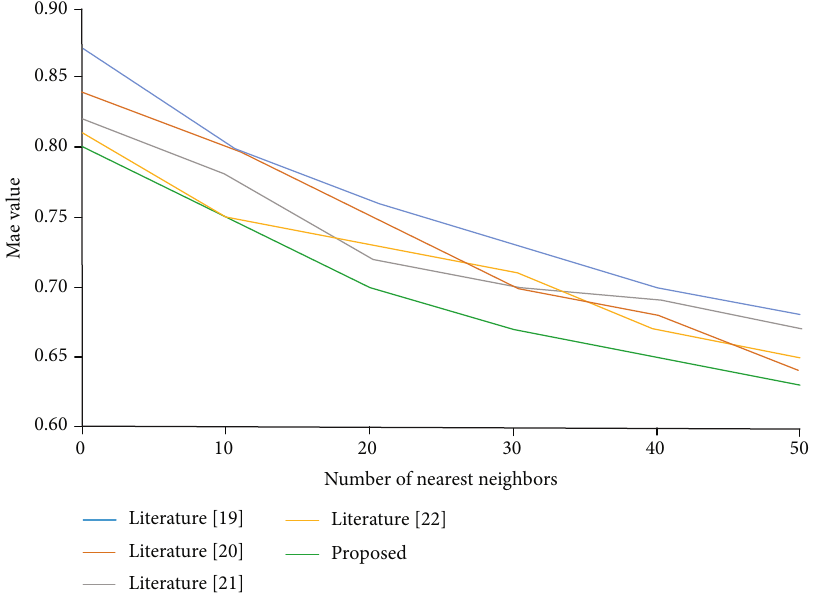
Figure 6: MAE values of each algorithm. Table 3: RMSE values of each algorithm.